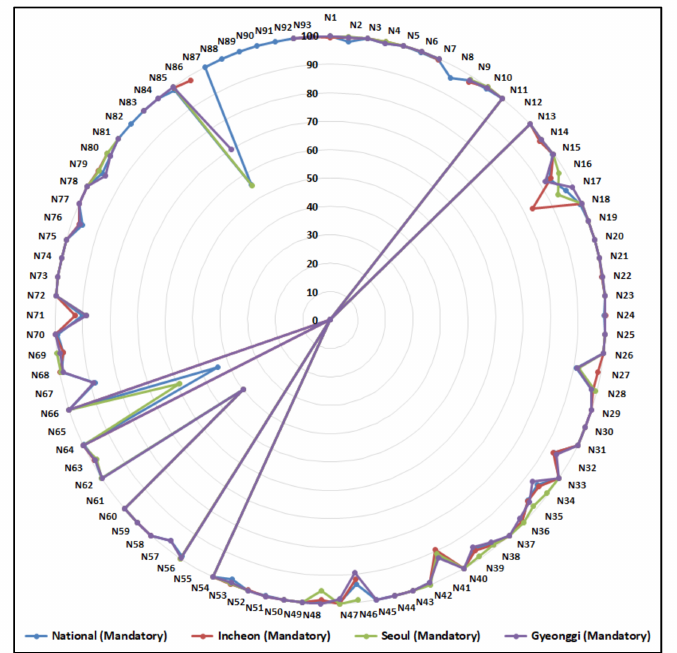
Figure 8. Radar chart showing region-specific DCR of South Korea’s OGD considering mandatory data